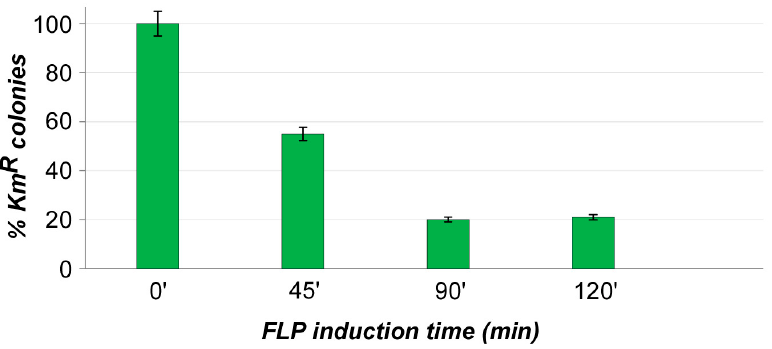
Figure 2. FLP-mediated KmR cassette excision. The resistance cassette loss was measured over time after FLP induction. The percentage was calculated as KmR/total plate count.